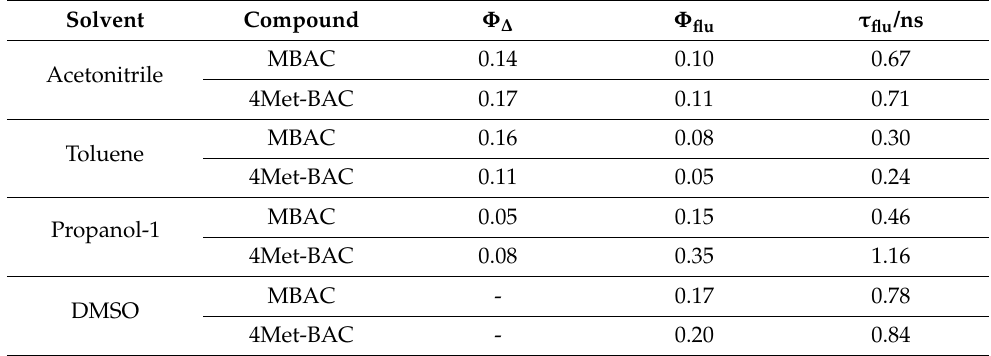
Table 2. Photochemical characteristics of studied compounds in different